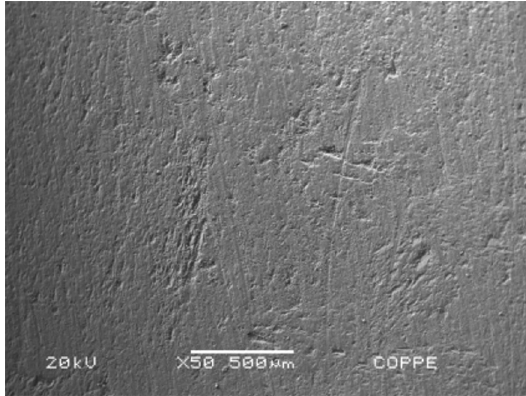
Figure 4. SEM micrograph of the polished surface of commercial Stellar TM artificial stone.